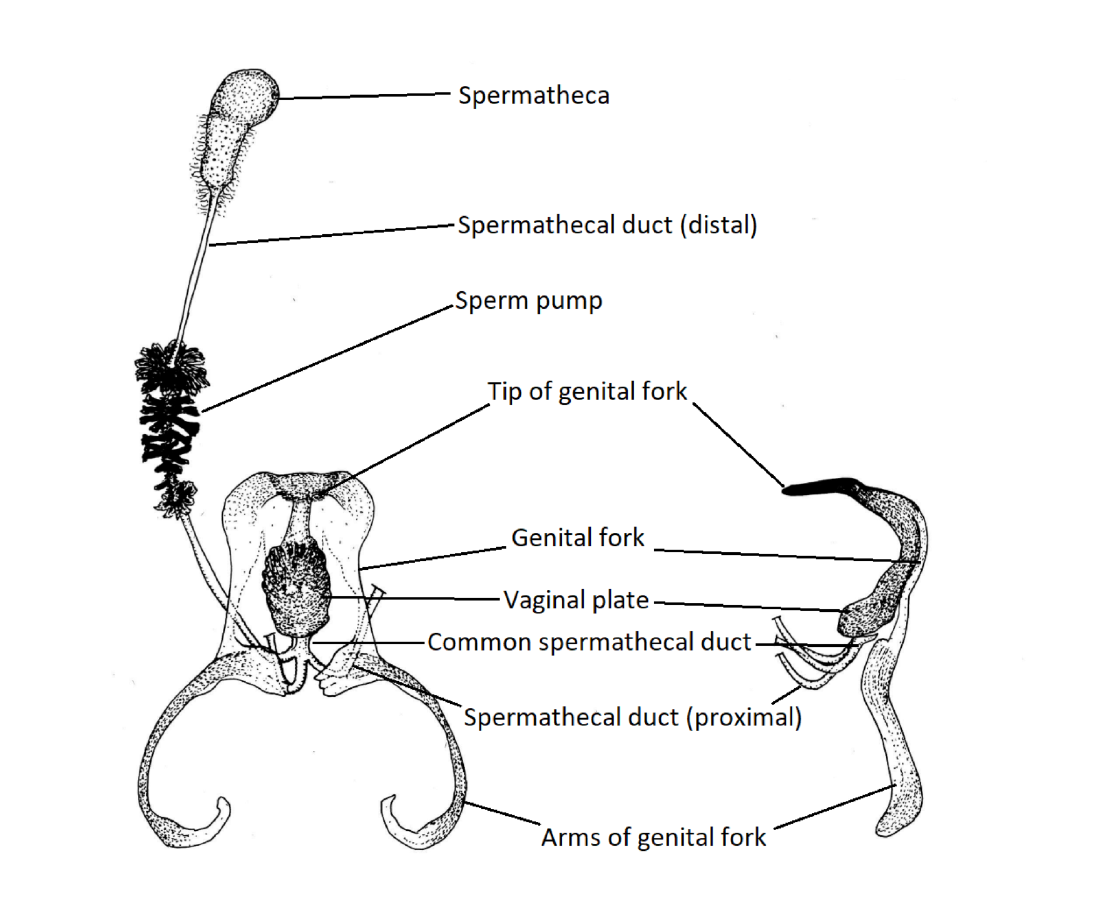
Fig. 70. Female internal genitalia. Note that the vaginal plate can be fused to the genital fork to the extent that it is not differentiated, particularly in Parusia gen.